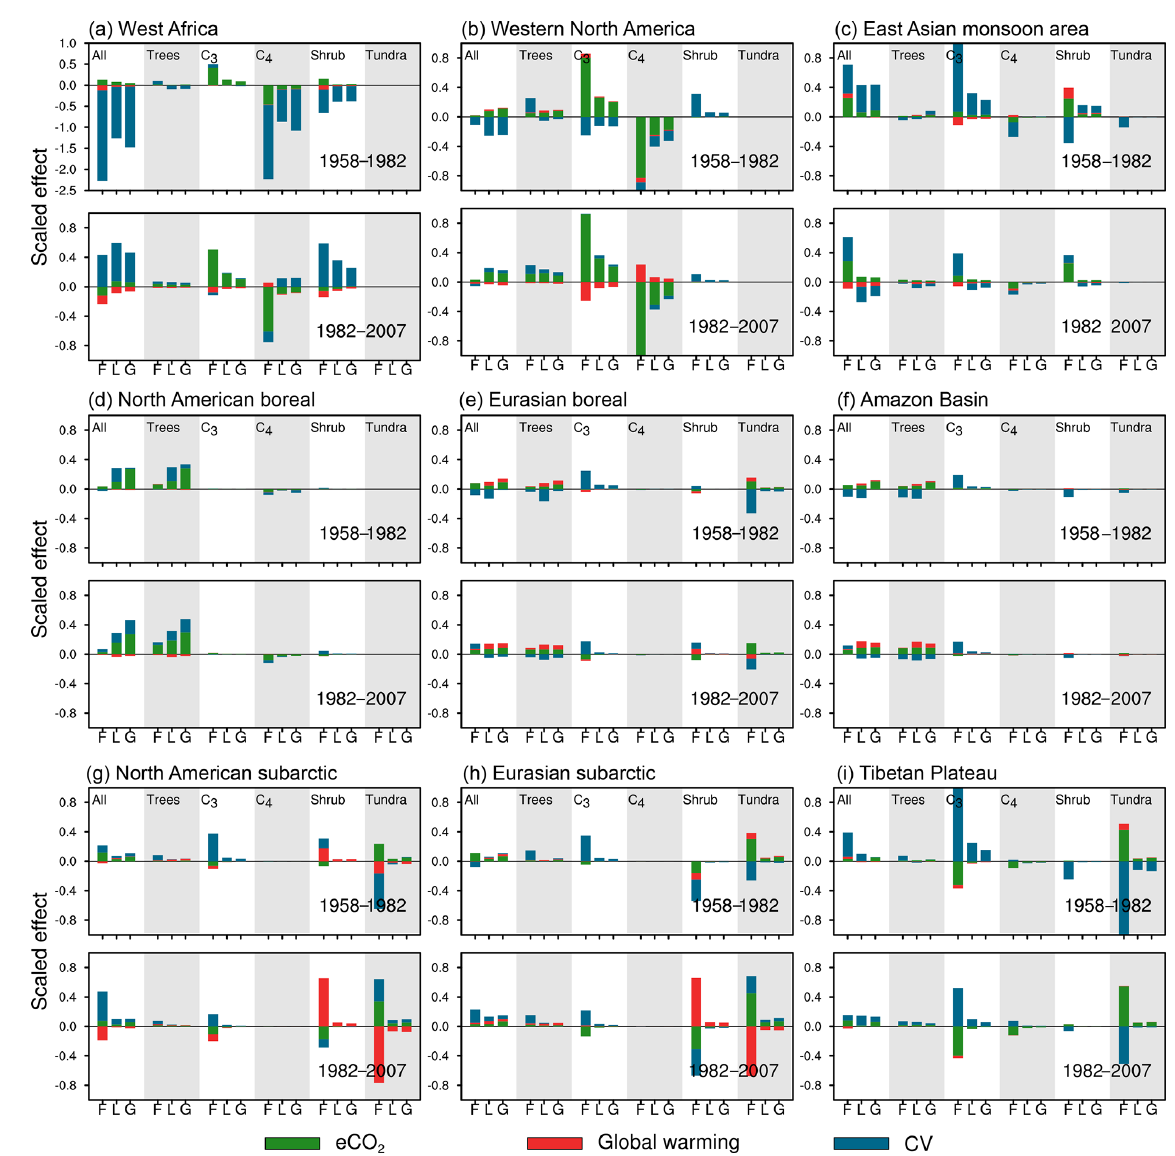
Figure 11. Contribution of each factor on FRAC (denoted as “F”), LAI (denoted as “L”), and GPP (denoted as “G”) trends over subregions. For panels (a–i) , the upper sections indicate trends during 1958–1982 and lower sections indicate trends during 1982–2007. The effects of eCO 2 , global warming, and CV are shown in green, red, and blue bars, separately. Each column shows the effects on all PFTs (All), trees, C 3 grasses (C 3 ), C 4 plants (C 4 ), shrub, and tundra, separately. The numbers for FRAC, LAI, and GPP are normalized by dividing the standard deviation of global average in the control